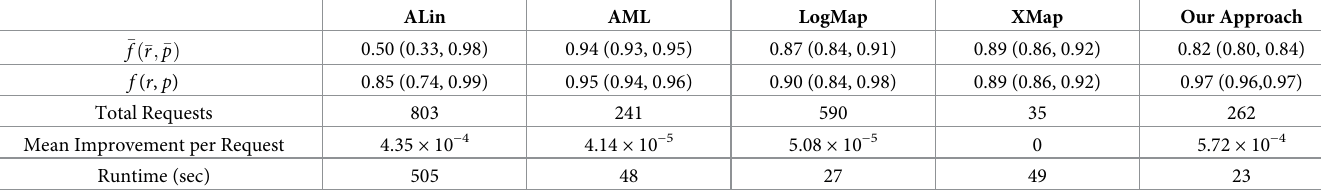
Table 1. Comparison between OAEI 2016’s participants and our approach on interactive anatomy track.